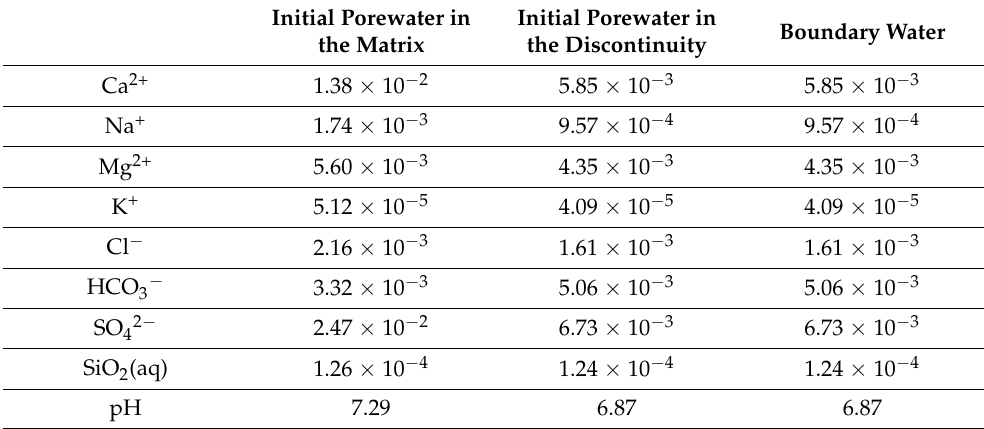
Table 3. Chemical compositions of the boundary water and the initial porewaters used in the reactive transport model (values in mol/L). Initial Porewater in Initial Porewater in Boundary the Matrix the Discontinuity